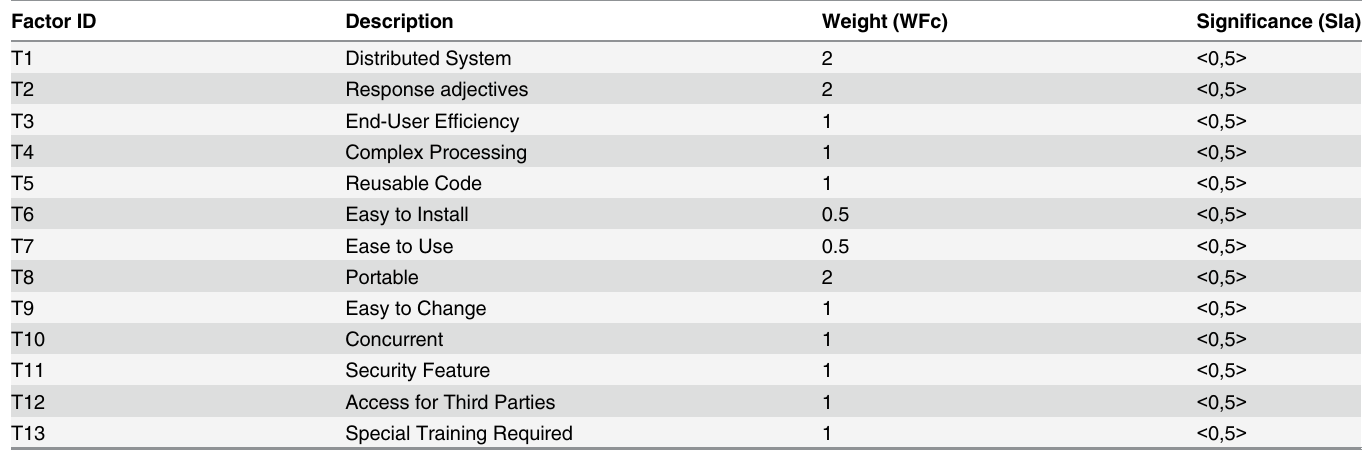
Table 3. Technical Factors.